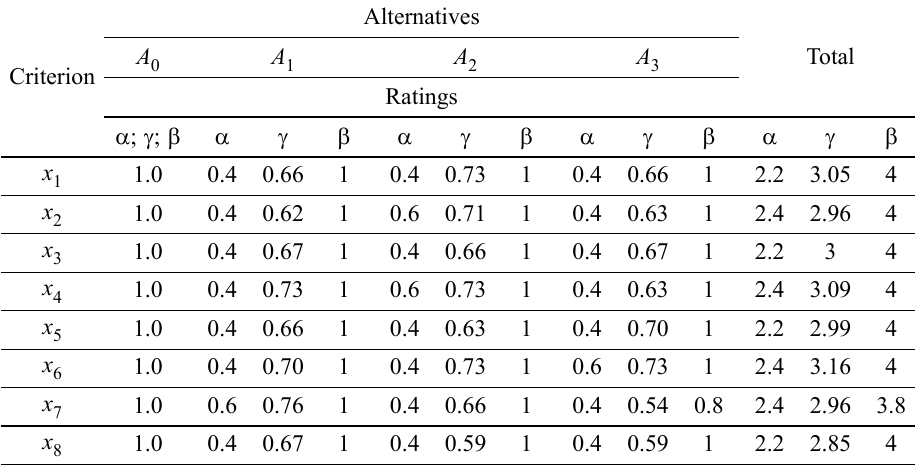
Table 7 . The fuzzy decision making matrix with aggregate weights (all criteria should to be maximized and optimal value equals to 1.0)